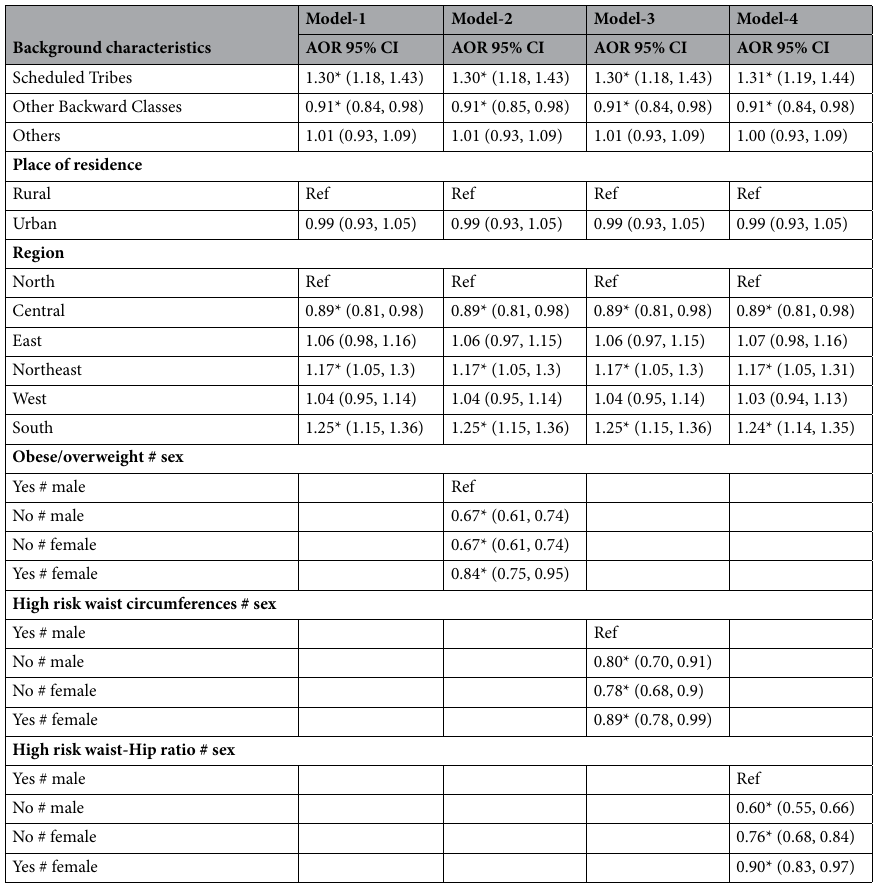
Table 2. Logistic regression estimates for hypertension among older adults in India, 2017–18 Ref: Reference; #: Interaction; *if p < 0.05; AOR: Adjusted Odds Ratio; Model-1 represents the adjusted odds ratio adjusted for all background characteristics; model-2, 3 and 4 were adjusted for all the background characteristics and represents the interaction